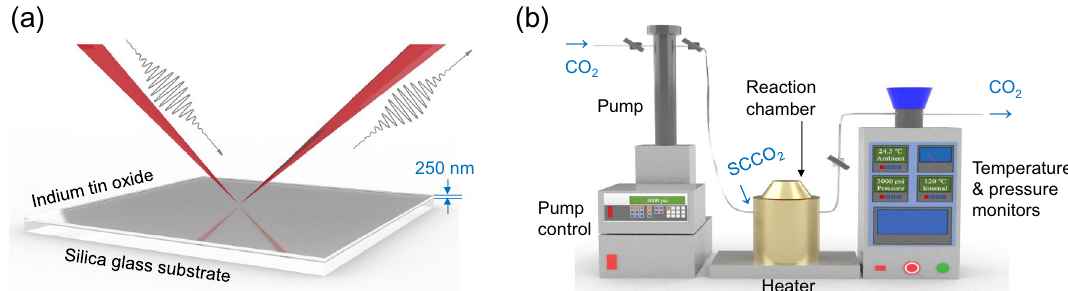
Figure 1. Schematic diagrams of the sample and the SCF processing. ( a ) The ITO nanolayer sample under VASE measurement; ( b ) The SCF processing system with pressure and temperature control and monitoring.